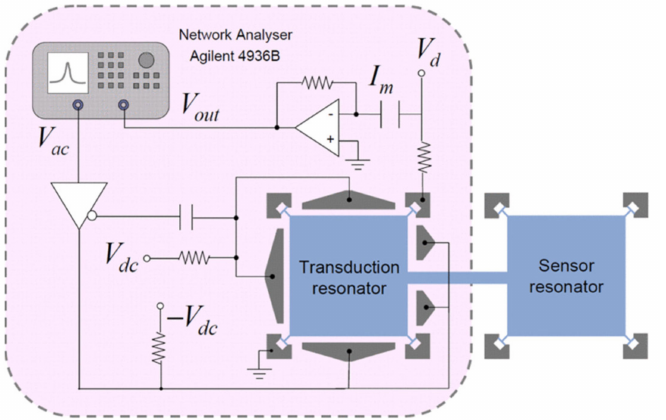
Figure 17. Measurement setup for a coupled BAW resonator system using capacitive actuation and piezoresistive sensing (Reprinted with permission from Ref. [40]).